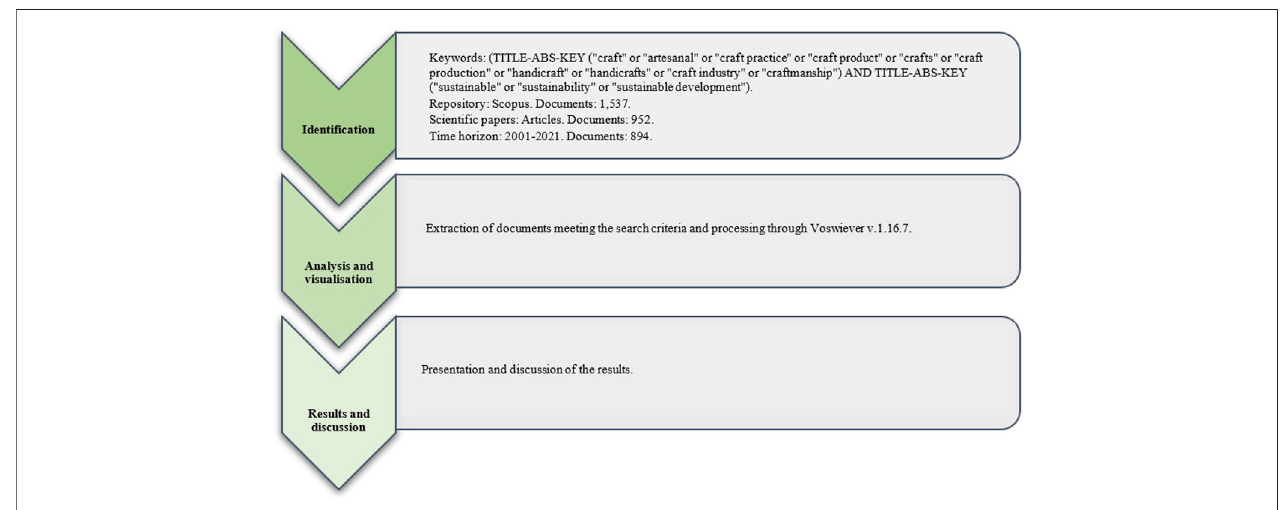
FIGURE 1 | Applied bibliometric analysis methodology. Source: Authors ’